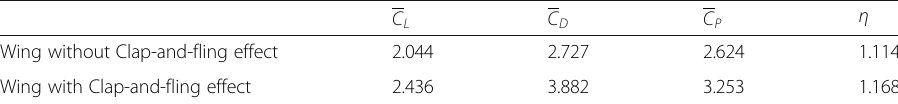
Table 3 Average aerodynamic coefficient and efficiency of wing with or without clap-and-fling effect